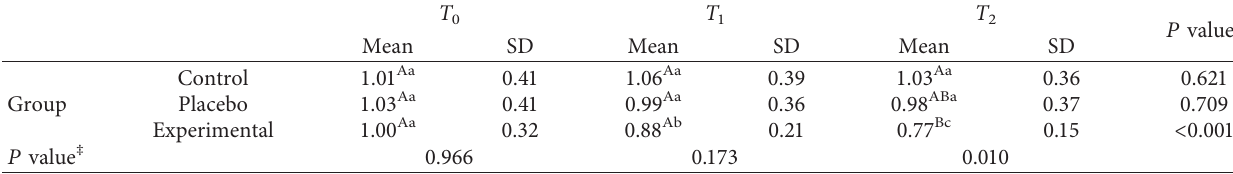
Table 4: Comparison of the mean gingival index (GI) from T 0 to T 2 in control, placebo, and experimental groups (mean ± SD). T 0 T